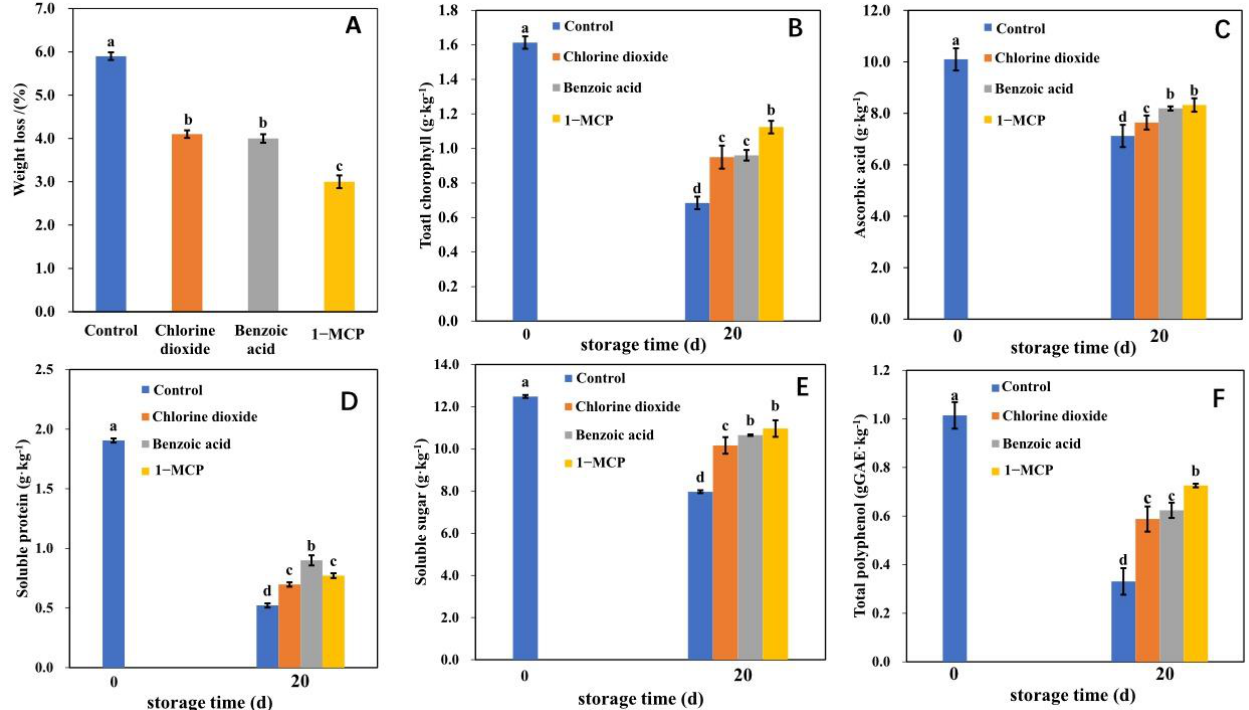
Figure 1. The phenotype of postharvest flowering Chinese cabbage treated with benzoic acid, chlorine dioxide, and 1-MCP was stored at 4 ℃ for 20 days. ( A ) control group, ( B ) chlorine dioxide treated group, ( C ) benzoic acid treated group, and ( D ) 1-MCP treated group.